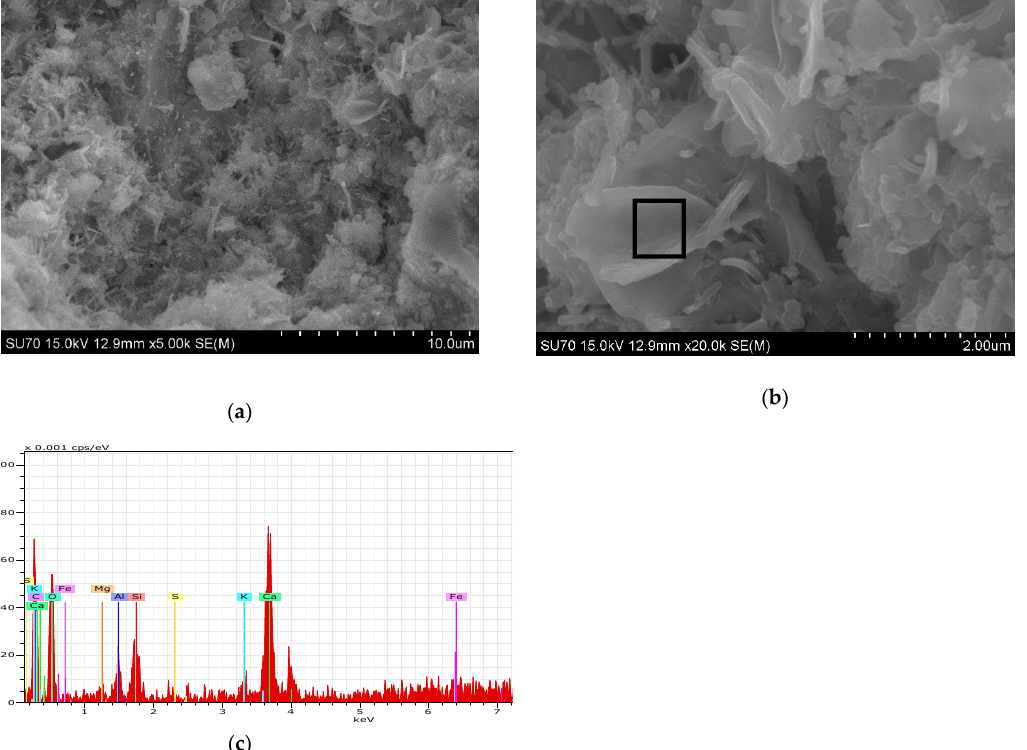
Figure 7. ( a , b ) 17_NCT mortar SEM micrographs, ( c ) EDS spectrum from zone identified in ( b ).